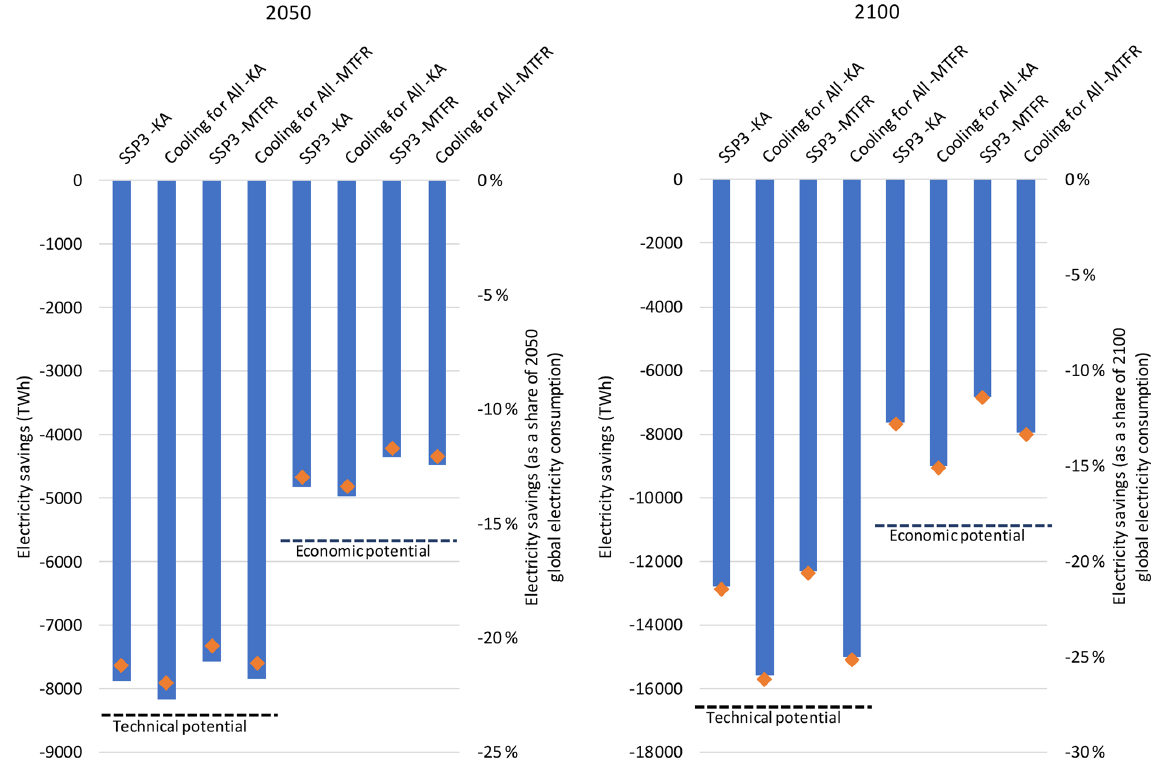
Figure 4. Annual electricity-saving potentials when moving from pre-Kigali baselines (SSP3 and Cooling for All) to HFC reduction scenarios (Kigali Amendment – KA and maximum technically feasible reduction – MTFR), in absolute terawatt hours (TWh) (blue bars) and as a fraction of expected future global electricity consumption in the AIM/CGE SSP3 baseline scenario (Riahi et al., 2017) (orange